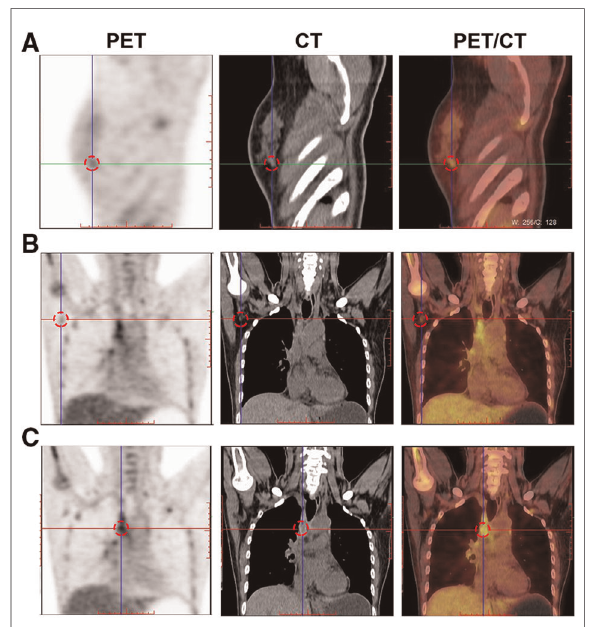
FIGURE 4 Breast molecular imaging fi ndings from patients with invasive ductal carcinoma with micropapillary features ( A ) A soft, irregular tissue nodule is seen in the lower outer quadrant of the right breast, approximately 1.0 cm×0.8 cm in size, exhibiting abnormal increased uptake of 18 F-FDG. ( B ) Several small lymph nodes are visible in the right axilla. The larger ones are approximately 1.2 cm×0.7 cm in size and exhibit mildly increased uptake of 18 F- FDG. Abbreviations: PET, positron emission tomography; CT, computed